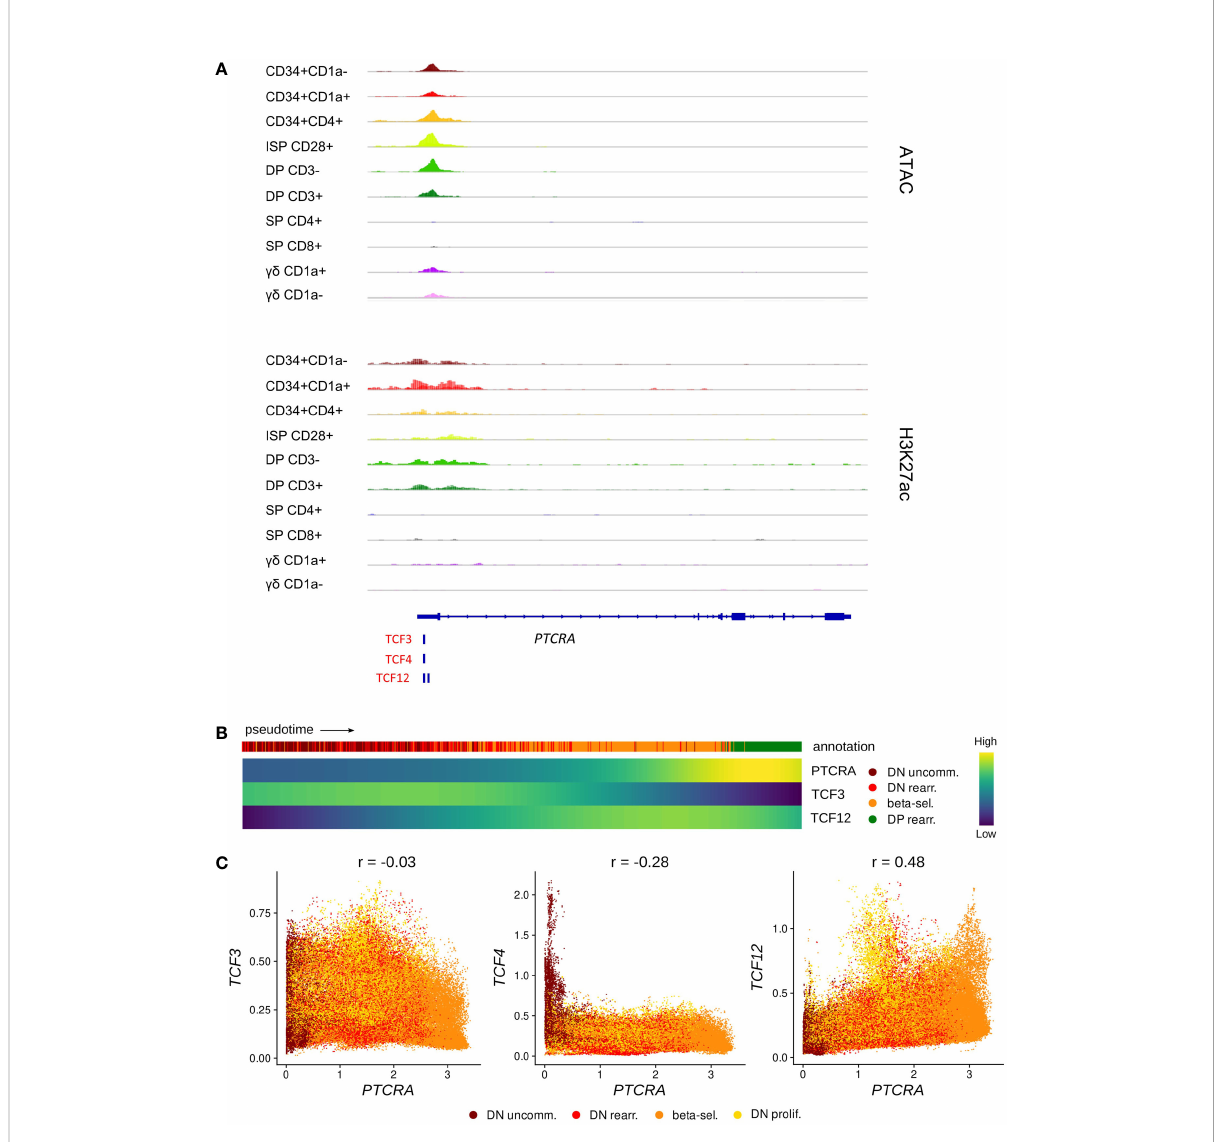
FIGURE 6 TCF12 is predicted to act as positive regulator of PTCRA transcription. (A) Genome browser view of ATAC, H3K27ac and E protein motifs in the PTCRA promoter region. Locations of promoters (P) and enhancers (E) were queried in the Ensembl Regulatory Build but none were found for this locus. (B) Heatmap showing gene expression along differentiation pseudotime in immature thymocytes. Smoothed gene expression was determined based on a generalized additive model fi tted on the cell pseudotimes, cells in pseudotime window of interest were selected and expression was scaled by gene prior to visualization. (C) Scatter plot for imputed transcript levels of E protein encoding genes and PTCRA in immature thymocytes. Cells are colored by cluster and Pearson correlation coef fi cient is